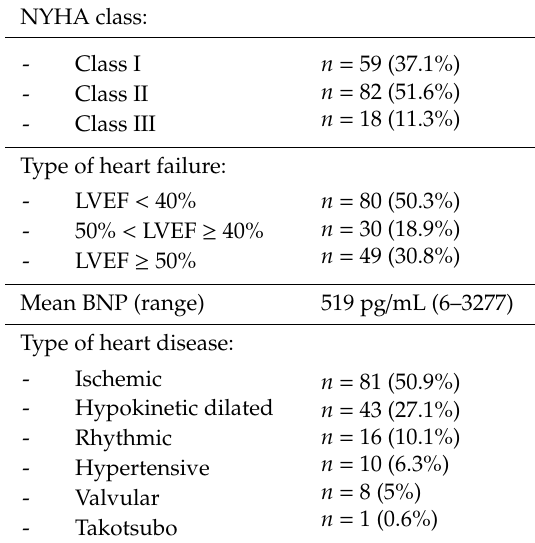
Table 1. Characteristics of the patients included in the USICAR ( Unit é de Suivi des Patients Insu ffi sants Cardiaques ) program.